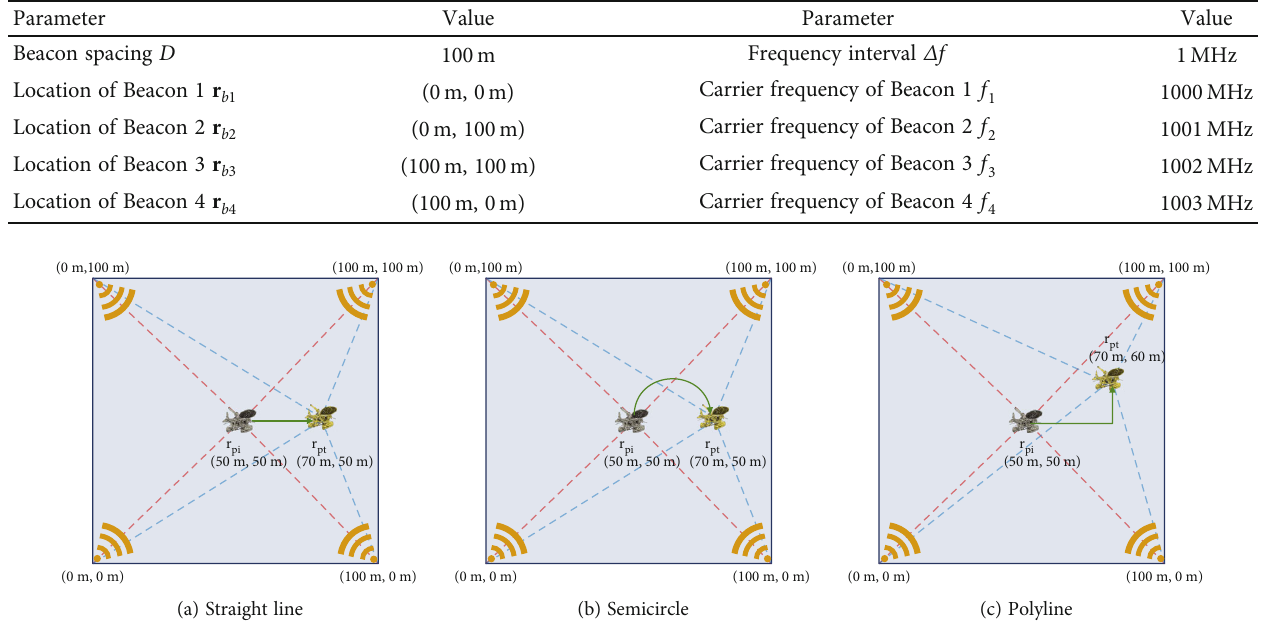
Table 2: Simulation parameters for lunar probe positioning.